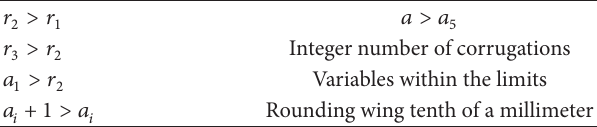
Table 2: Constraints in the antenna